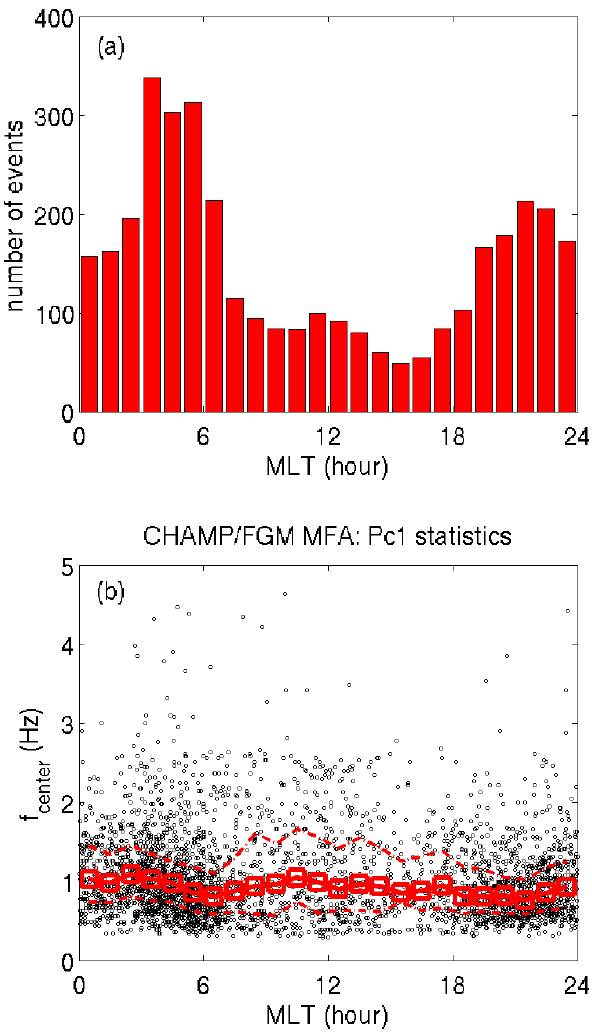
Fig. 5. Annual variation of Pc1 occurrence rates separately for (a) Northern and (b) Southern Hemisphere. 12:00 MLT. The dependence of the center frequency on